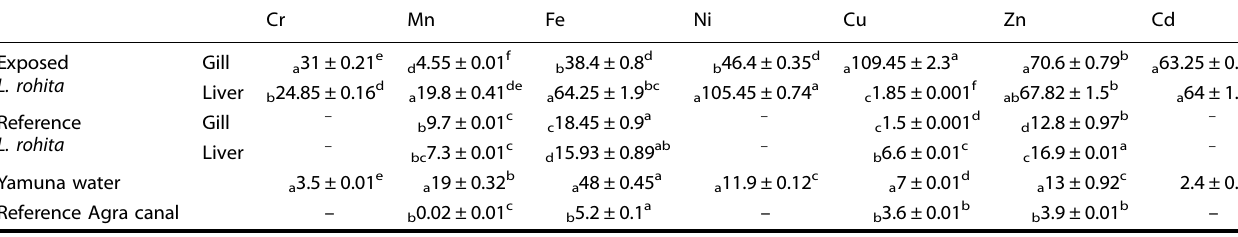
Table 1. Concentrations of heavy metals in Labeo rohita tissues (mg/kg.dw) and in water (mg/L). Cr Mn Fe Ni Cu Zn Cd Exposed L. rohita